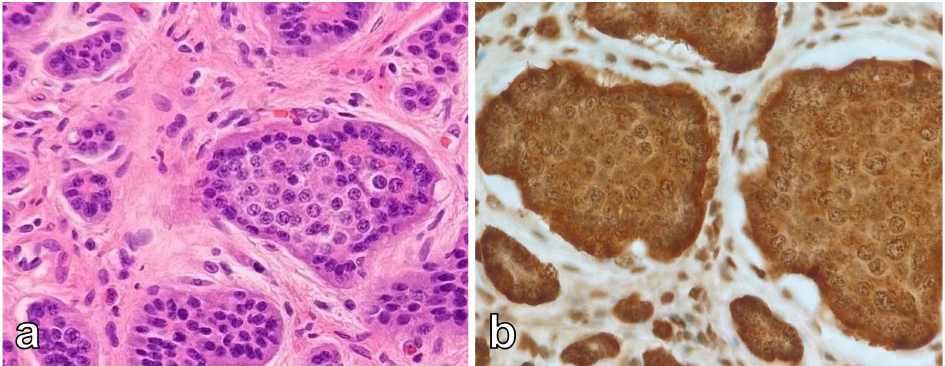
Figure 5. Histologic analysis and immunohistochemistry. Well differentiated neuroendocrine tumor with organoid architecture ( a ). Chromogranin diffuse positive reaction ( b